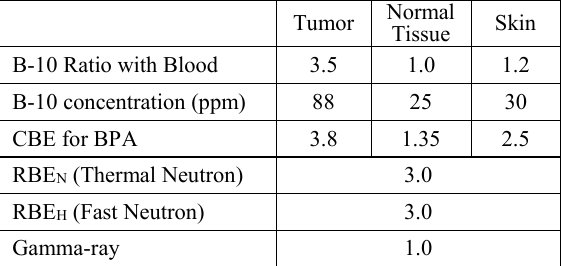
Table 2. Parameters required to the equivalent dose. Tumor